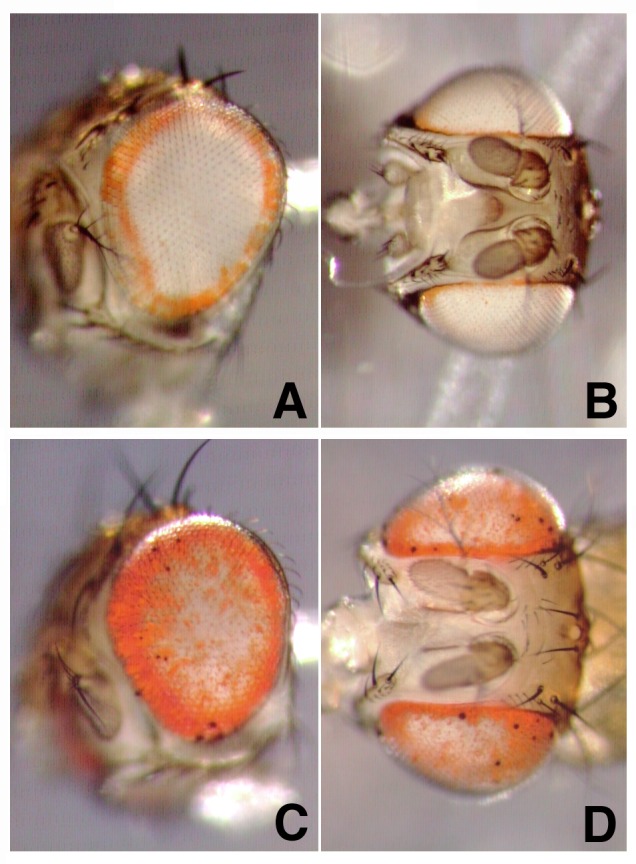
The effect of baculovirus P35 expression on pugD.A, B: eyes from v; pugD/+ flies. C, D: eyes from v; pugD
/P[GMR-P35] flies.